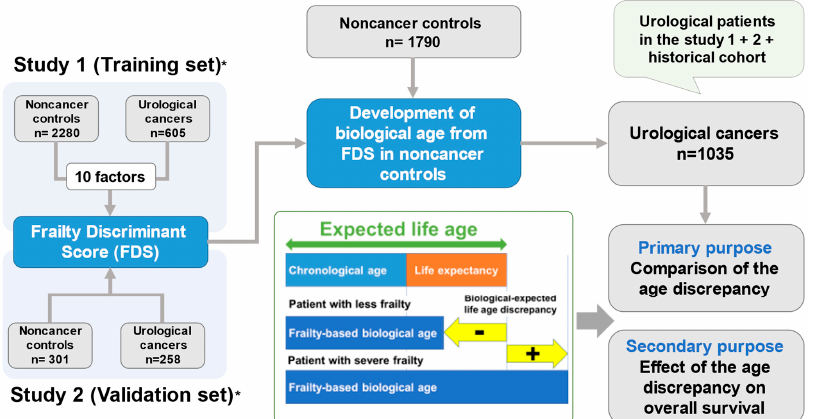
Figure 1. Study population and design. We developed the FDS in Study 1 (training set) and validated in the utility of FDS in Study 2 (validation set), which were reported in the previous study (*, refs [7,8]). The definition of the expected life age (years) = [ chronological age + life expectancy ].